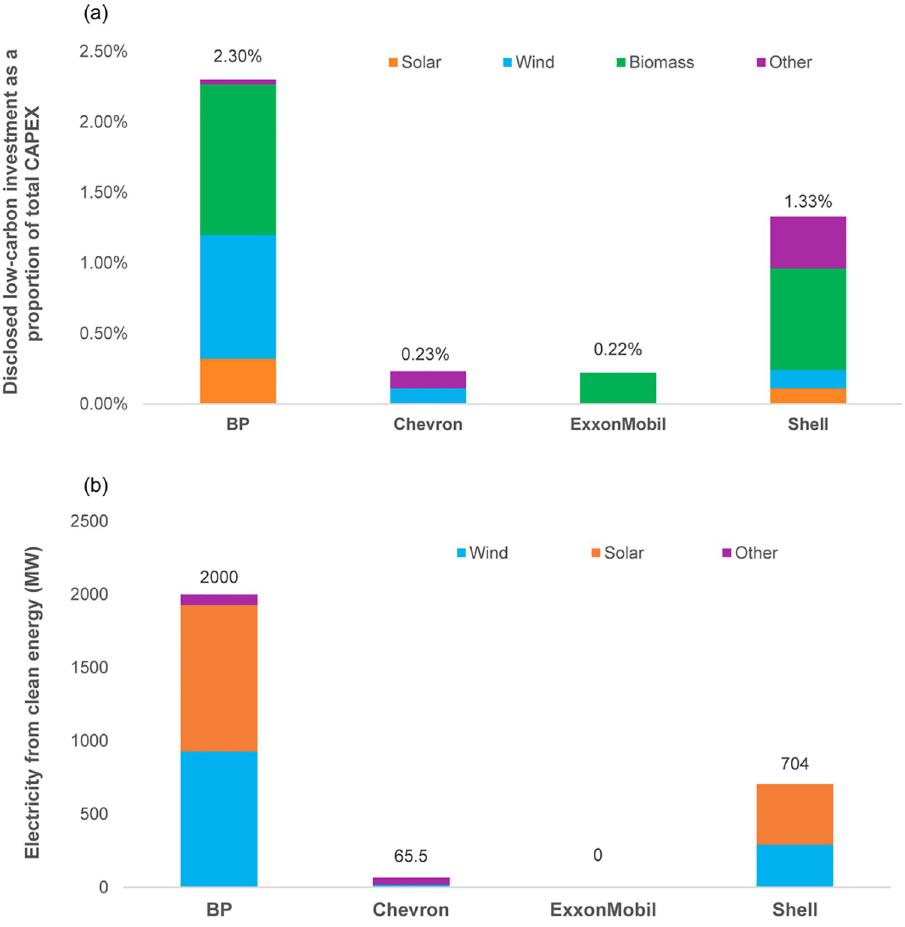
Fig 7. Low-carbon energy investment and electricity generation from clean energy. (a) Disclosed investment in low-carbon energy production and development, as a proportion of total CAPEX (2010–Q3 2018). Source: CDP Investor Research [81]. Note: “Other” indicates hydro; carbon capture, utilization, and storage (CCUS); frontier power; and smart technologies. (b) Electricity generation from clean energy (2009–2019). Source: S&P Global Platts [82]. Note: “Other” indicates other renewables used to generate